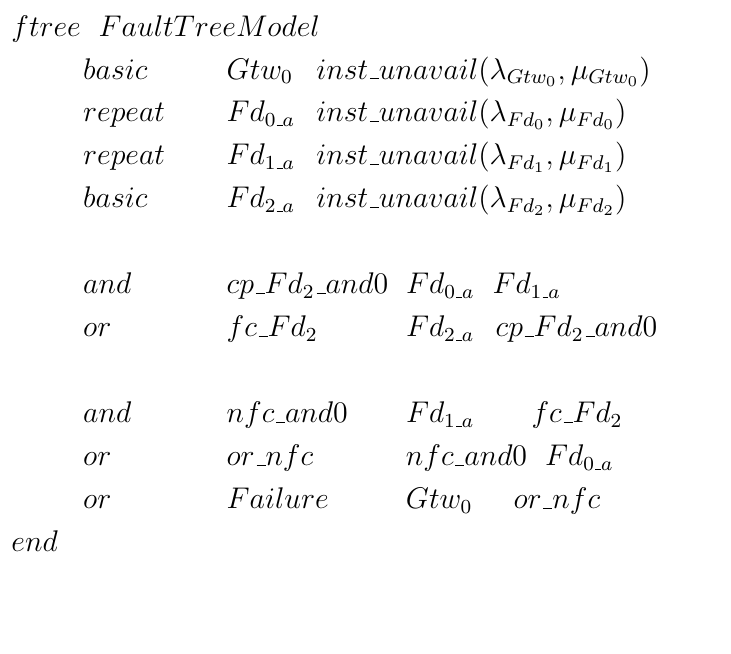
Figure 13. SHARPE source code generated by the proposed methodology and based on the fault tree of Figure